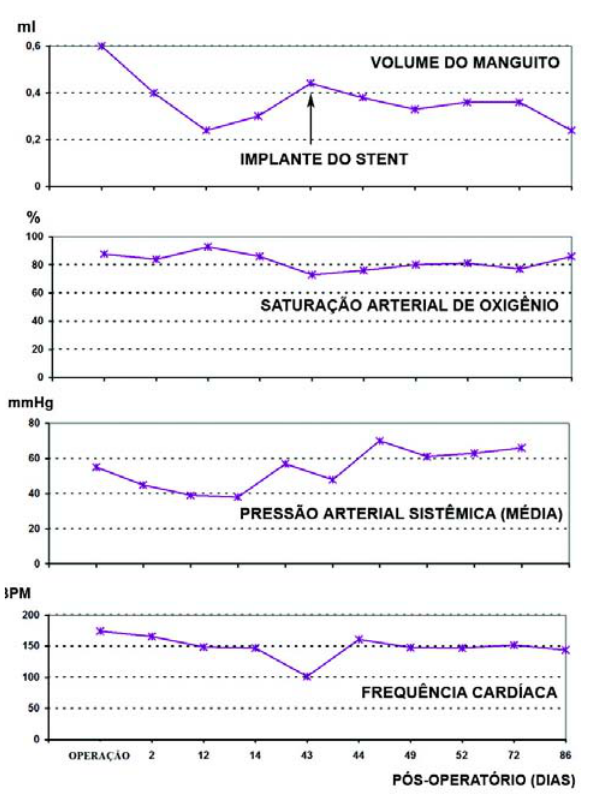
Fig.6 - Evolução hemodinâmica e da saturação arterial de oxigênio durante os ajustes das bandagens